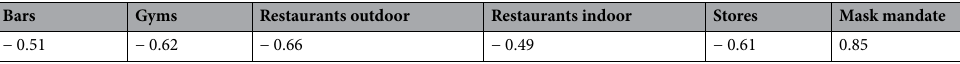
Table 3. The Pearson correlation coefficients of six different categories of policies and the ratio between actual and projected death counts. The six categories are reopening of bars, gyms, outdoor restaurants, indoor restaurants, stores, and mask